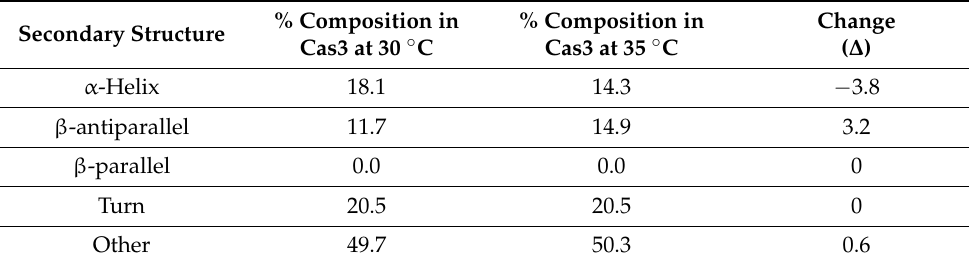
Table 1. Cas3 secondary structure from CD measurements at either side of the inflection point. a.